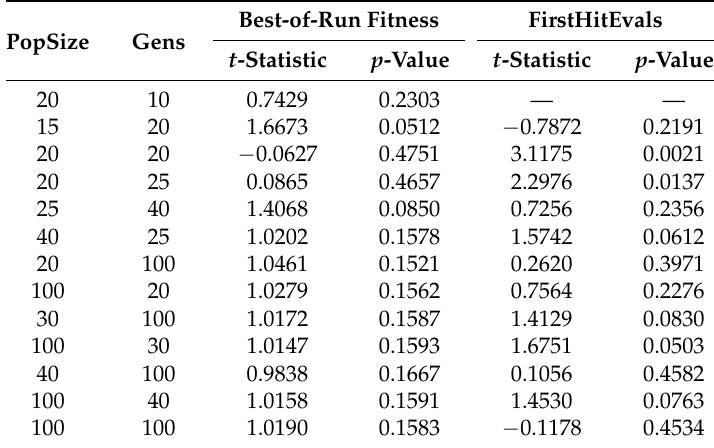
Table 10. Smith–Satterthwaite tests: Jaya vs. Sjaya on the fuel cell